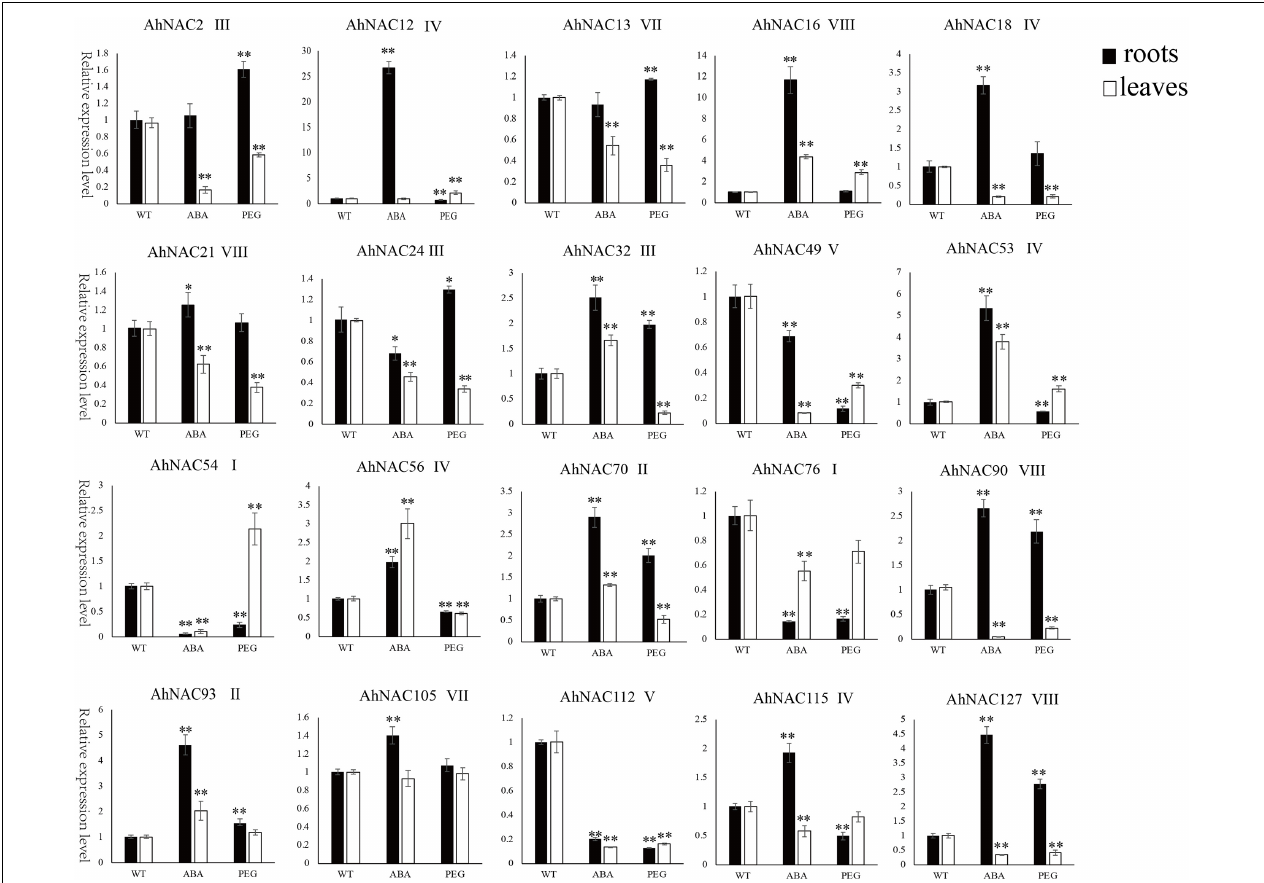
FIGURE 6 | The expression patterns of 20 AhNAC genes in roots and leaves after PEG and ABA treatment were verified by qRT-PCR. The relative expression levels of AhNAC genes in untreated peanut (WT) and PEG and ABA treated for 24 h were compared. Data were calculated from three biological replicates, and the significance of variants between the control and treatment groups was analyzed by one-way ANOVA. Significant differences at the levels of ∗ p < 0.05 and ∗∗ p < 0.01.